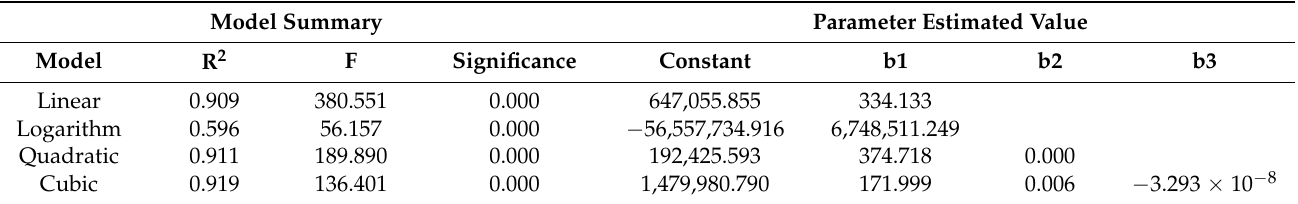
Table 2. Comparison of regression results.